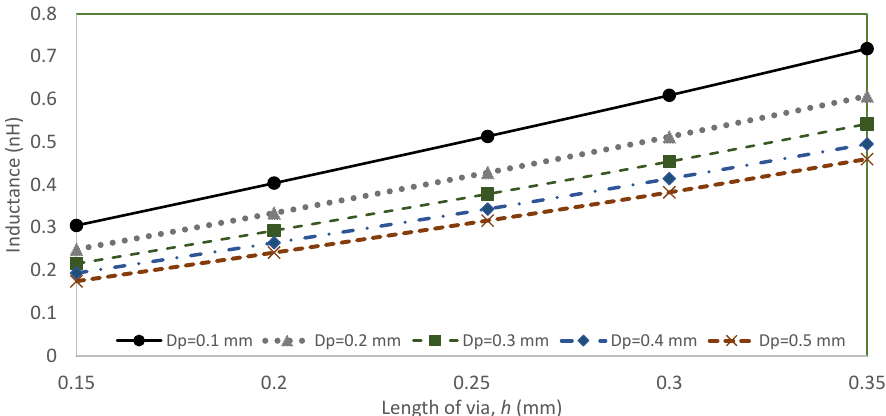
Figure 4. Via hole inductance as a function of length of via, h and different diameter of the microstrip via, D p . The strip line is analyzed using the NPC-F220A substrate with thickness of 0.254 mm, dielectric constant of 2.2 and tangent loss of 0.0007, and the Q factor is 554.7 from Equation (2). The strip line length, L 0 , and W 0 , are 7.75 mm and 0.84 mm, obtained from the com- puter simulation technology (CST) simulation by considering the impedance of 50 ohms and electrical length of 360 degrees at operating frequency of 28 GHz. Figure 5 shows the strip line configuration and the current distribution. The guided wavelength, λ g , is 7.2 mm, from (7) – (8) with a total length of 360°. Thus, a 0.02 mm line length produces 1° of phase delay. The additional strip-line, Δ L , can affect the insertion loss and phase shift. In this study, the length change, Δ L , is varied from 1 mm to 10 mm. The insertion loss and phase shift characteristic from the simulation can be seen in Figure 6, with 0.029 dB/mm and 47°/mm changes for every strip line dimension.